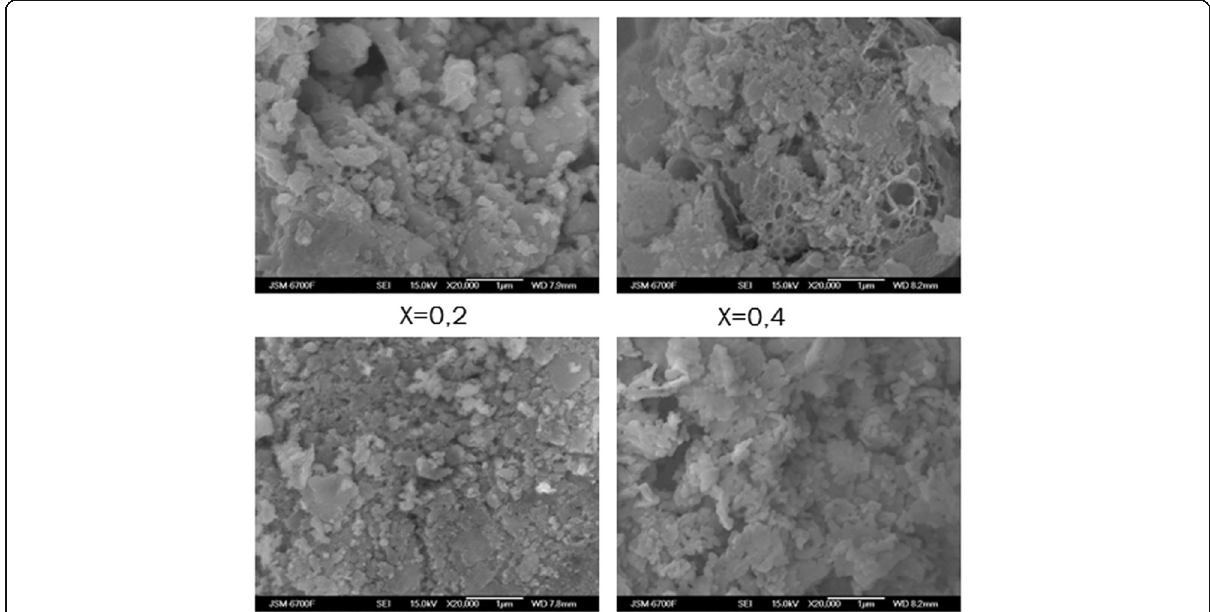
Fig. 6 Micrographs of the systems Li 0.5 Fe 2.5-x Mg x O